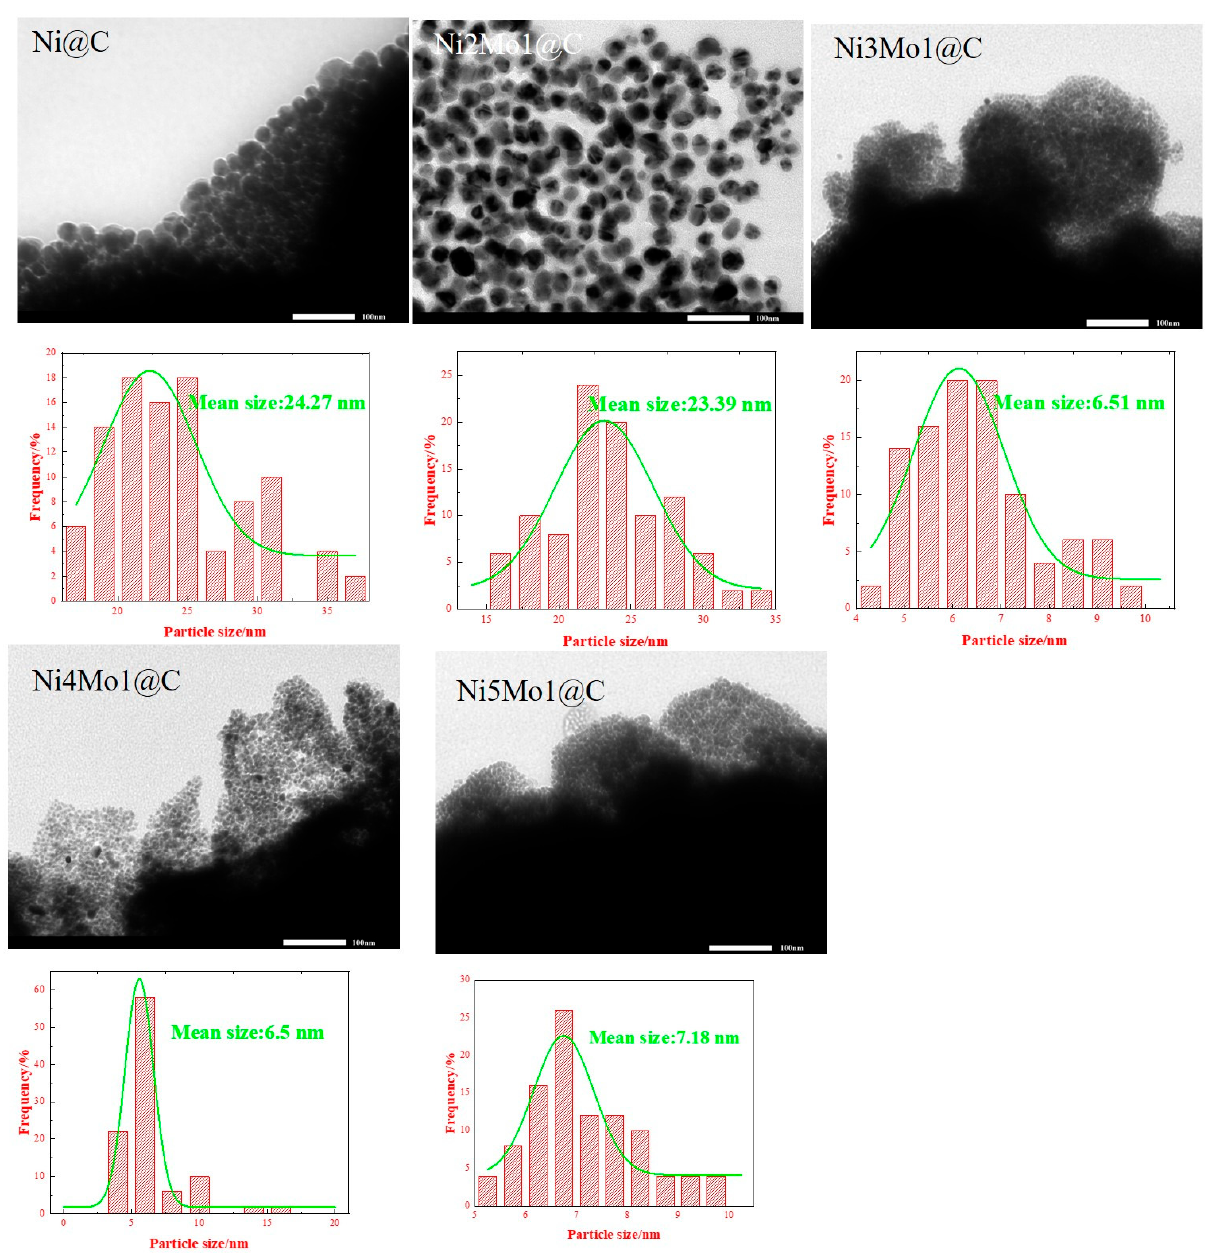
Figure 3. The TEM micrographs and particle size distribution of Ni@C, Ni2Mo1@C, Ni3Mo1@C,